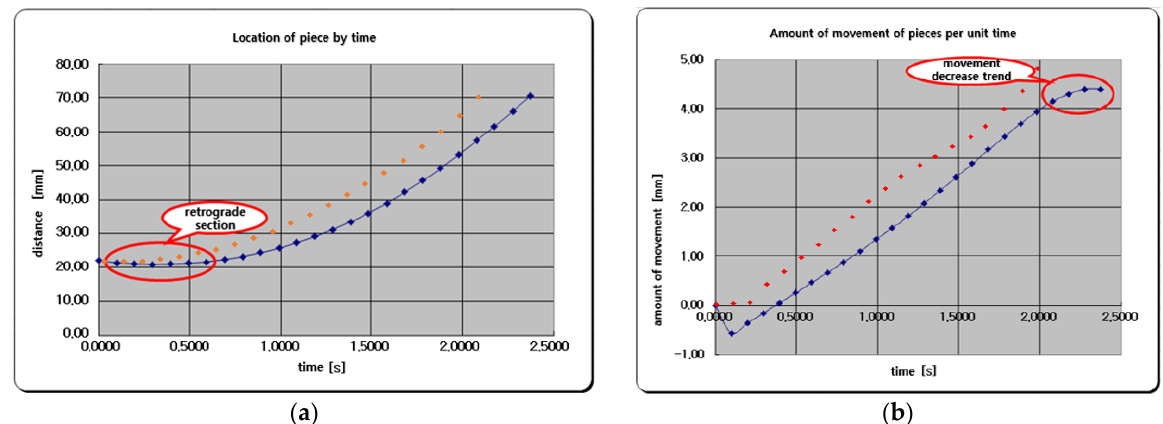
Figure 11. When the normal (orange) and spline (blue) curve of the slide plate rail was 40 degrees at a constant speed; ( a ) Location of piece over time; ( b ) Amount of movement of pieces per unit time. It stopped, due to interference, and then moved along the trajectory.